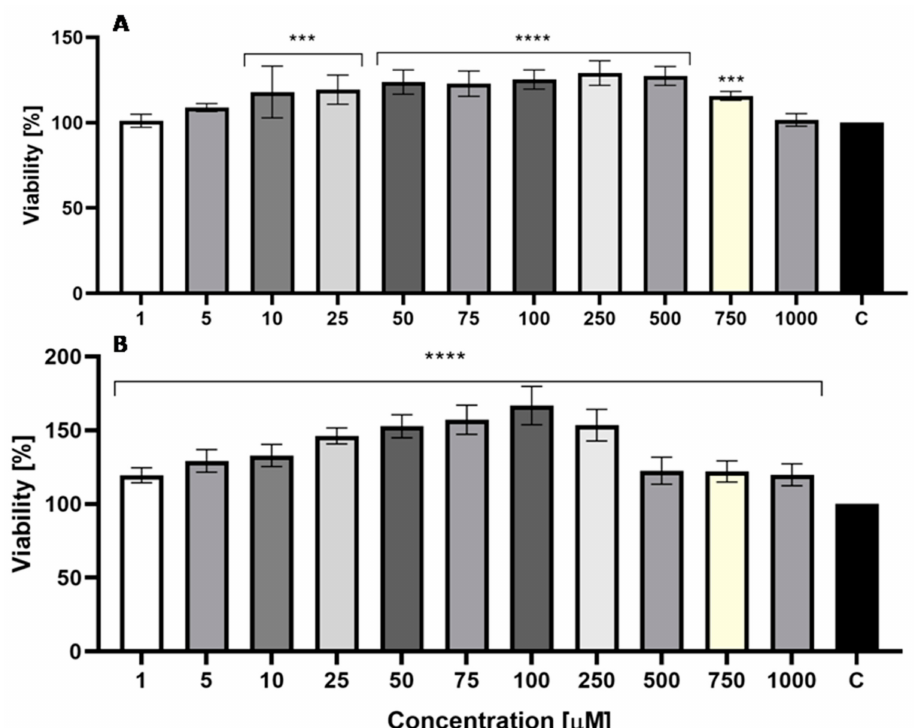
Figure 7. The reduction of resazurin after 2 h ( A ) and 24 h ( B ) of exposure to GEN (1–1000 µ M) in